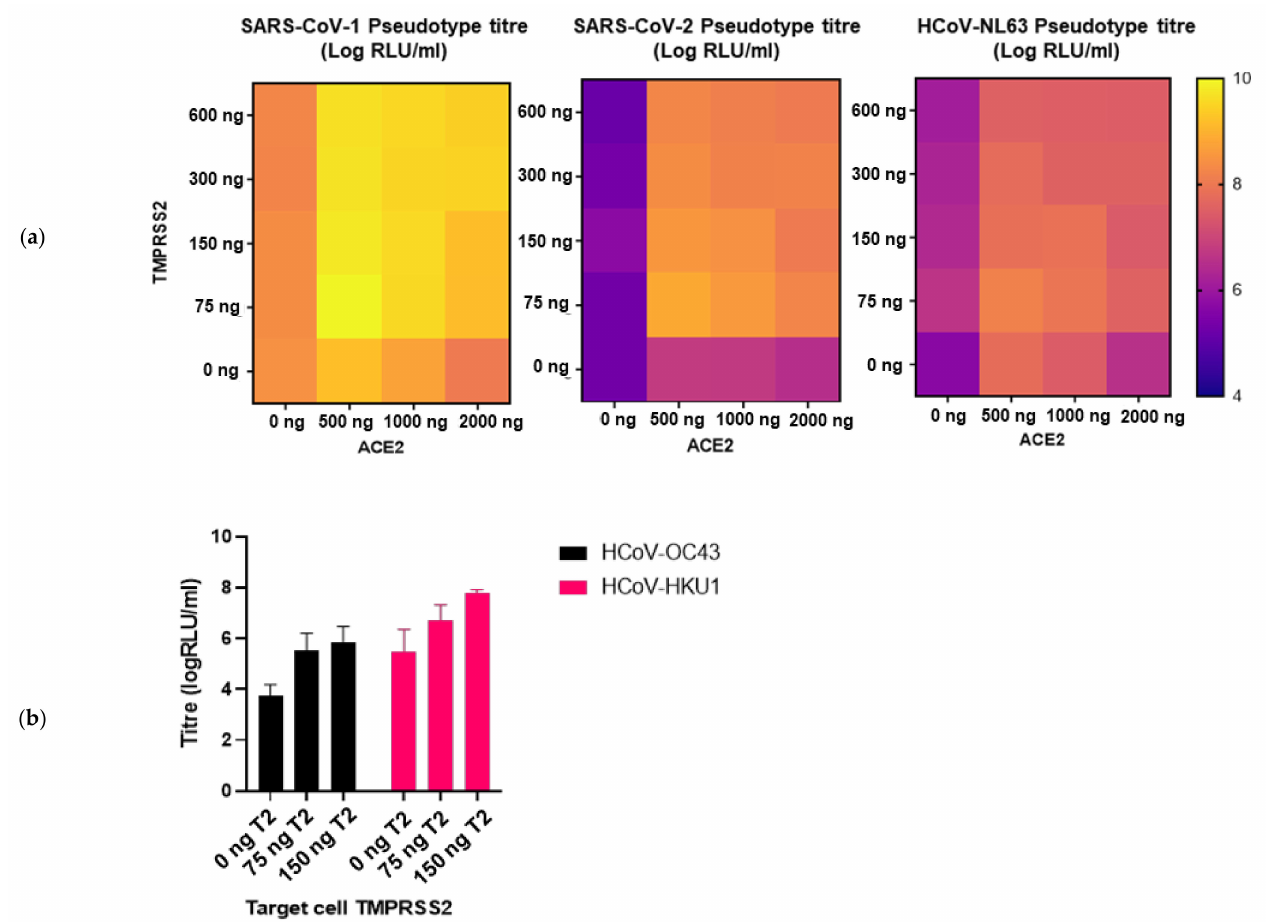
Figure 8. Enhancement of PV entry by target cell transfection: ( a ) Transfection of either HEK293T/17 cells or HUH7 cells with TMPRSS2 and ACE2 considerably boosted entry of the ACE2-using SARS-CoV-1, SARS-CoV-2 and HCoV-NL63 PVs. The optimal combination of ACE2 and TMPRSS2 for transfection into HEK293T/17 cells was determined for each PV—75 ng of TMPRSS2 expression plasmid and 500 ng of ACE2 expression plasmid supported the highest entry. ( b ) Entry of HCoV-HKU1 and HCoV-OC43 was enhanced by transfection of HEK293T/17 cells with